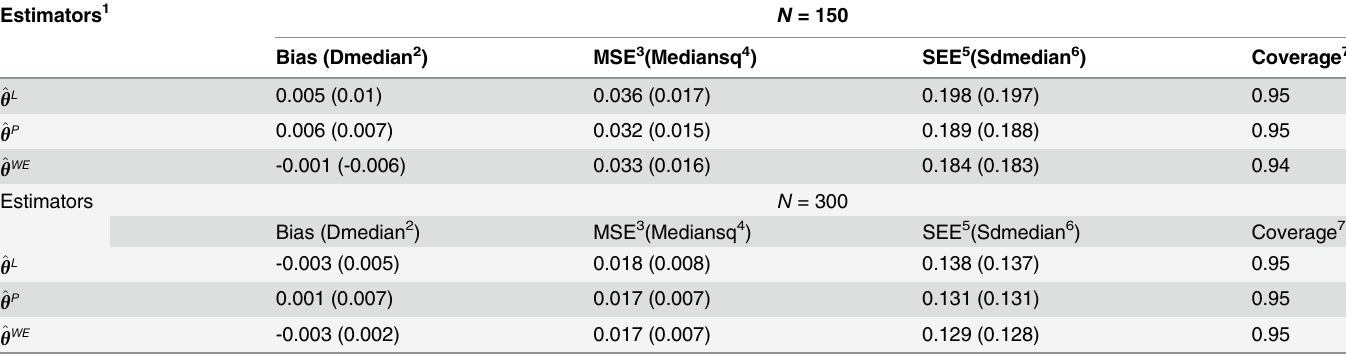
Table 2. Simulation result when N = 150 and N = 300, ρ = 0.25 with covariate